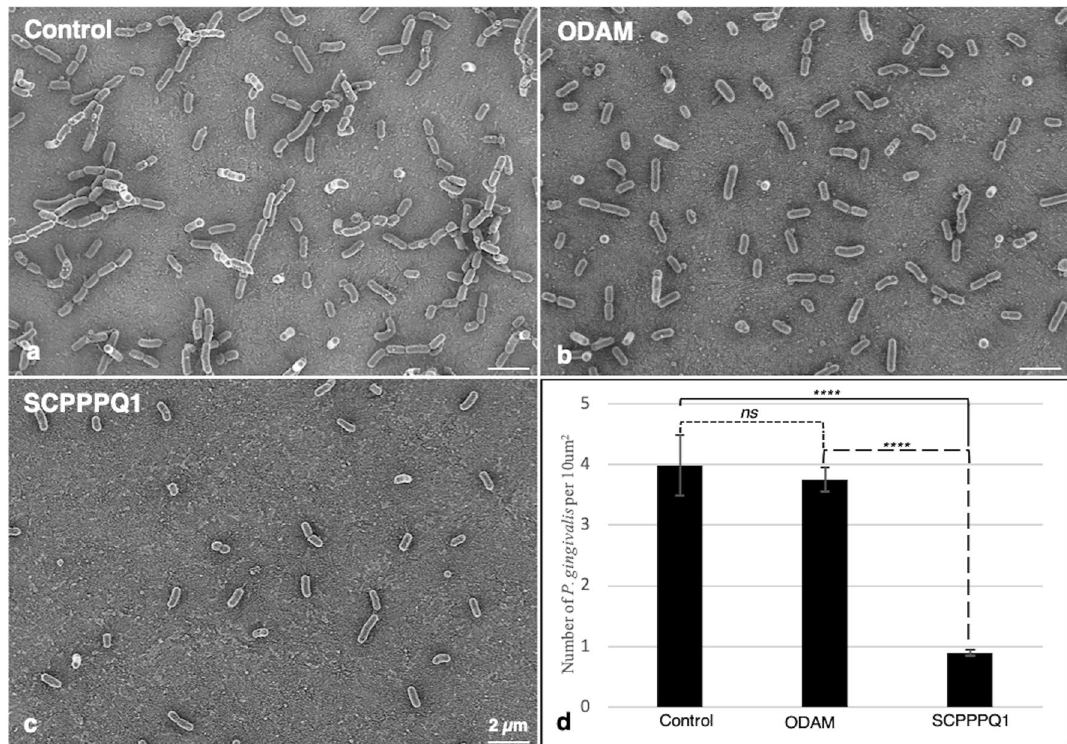
Figure 3. Scanning electron microscopy (SEM) imaging of P. gingivalis . Cultures of P. gingivalis were incubated in ( a ) the absence (buffer only, control), or presence of ( b ) ODAM (20 µM) or ( c ) SCPPPQ1 (20 µM) for 2 h. Bacteria were then deposited on titanium disks, allowed to adhere for 30 min and processed for SEM imaging. Both qualitative ( a–c ) and quantitative ( d ) analysis reveal an important decrease in the number of P. gingivalis when incubated with SCPPPQ1 compared to ODAM or buffer as controls. Representative pictures from one experiment are depicted. T-test analysis was used to determine the significance of the quantification in comparison to the control (means ± SD; n = 5). ns not significant; **** p <